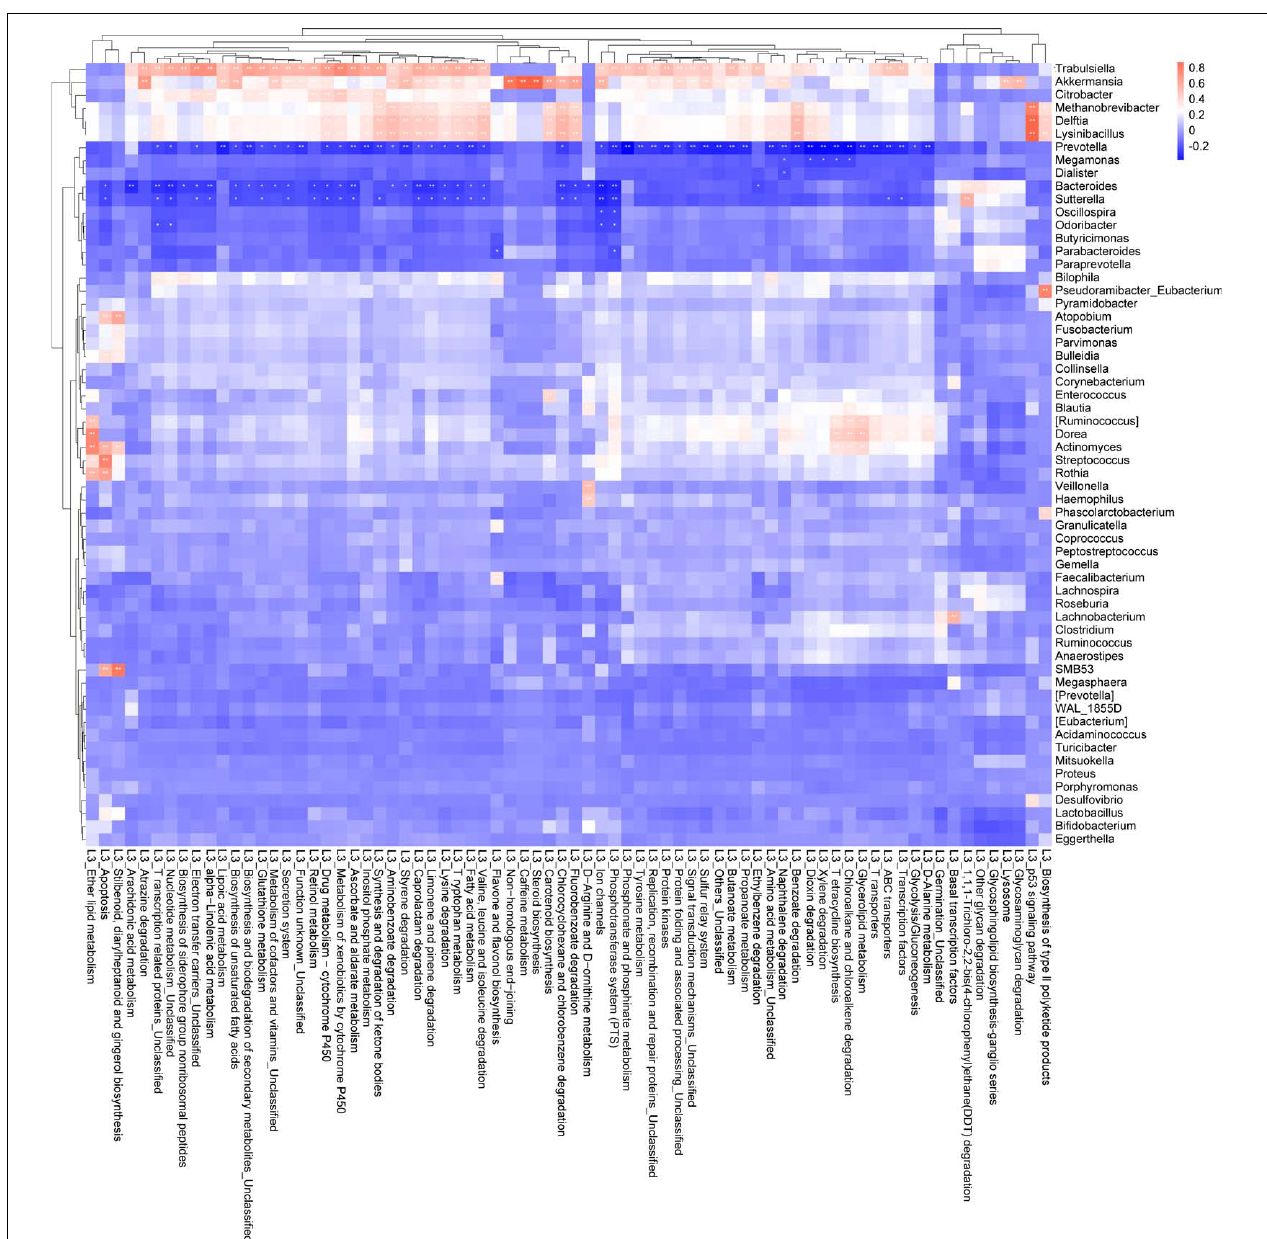
FIGURE 3 | Correlation analysis heat map of bacteria and KEGG